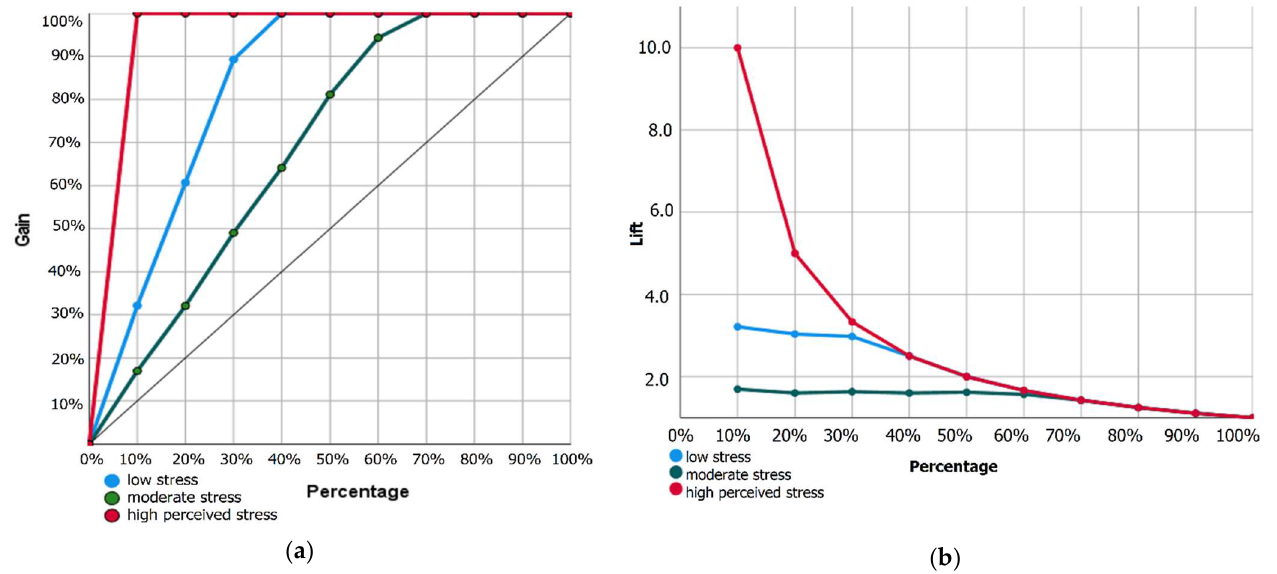
Figure 4. Model performance measurement: ( a ) cumulative gains that are the illustrations of accurate classifications gained by the ANN2 model; and ( b ) lift chart showing model performance in a portion of the population.